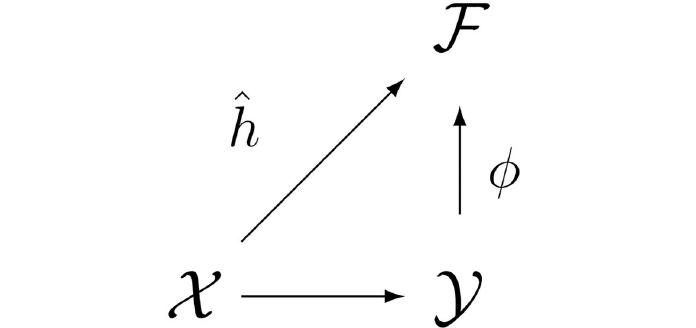
Fig 3. Arrow diagram of the Input-Output Kernel Regression (IOKR) framework. X denotes the space of MS2 spectra, Y is the space of metabolites, and F is the shared space of molecular fingerprints. ^ h is the (learned) mapping from MS2 to fingerprints, while ϕ is the (exact) mapping from metabolites to molecular fingerprints.